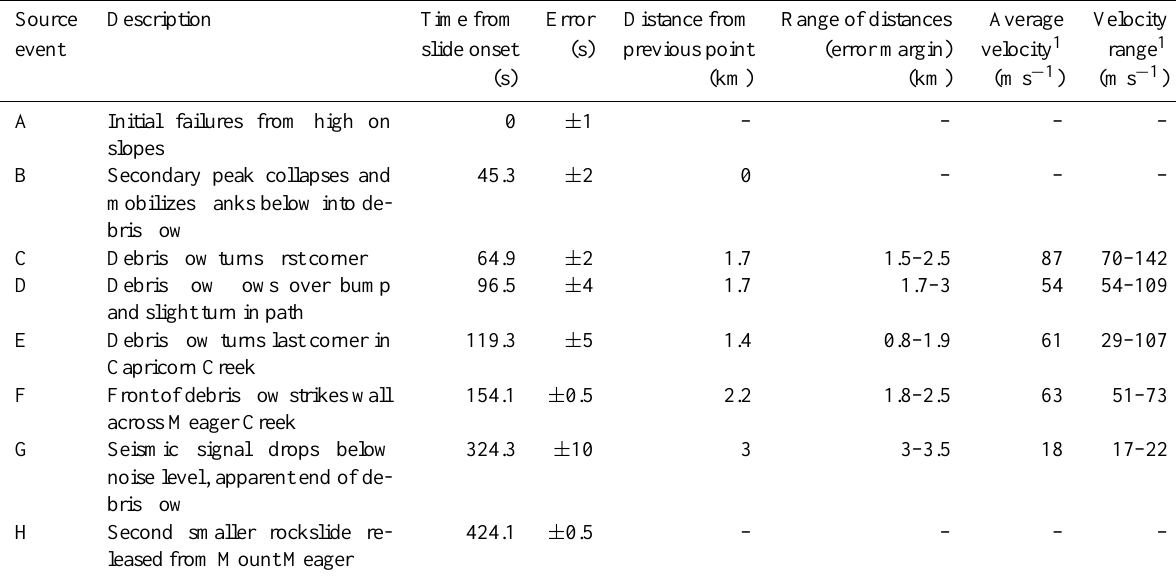
Table 2. Time markers along landslide path according to the seismic signature at stations in the Pacific Northwest (see Figs. 7–9 for path and station locations and seismic trace associated with each marker).